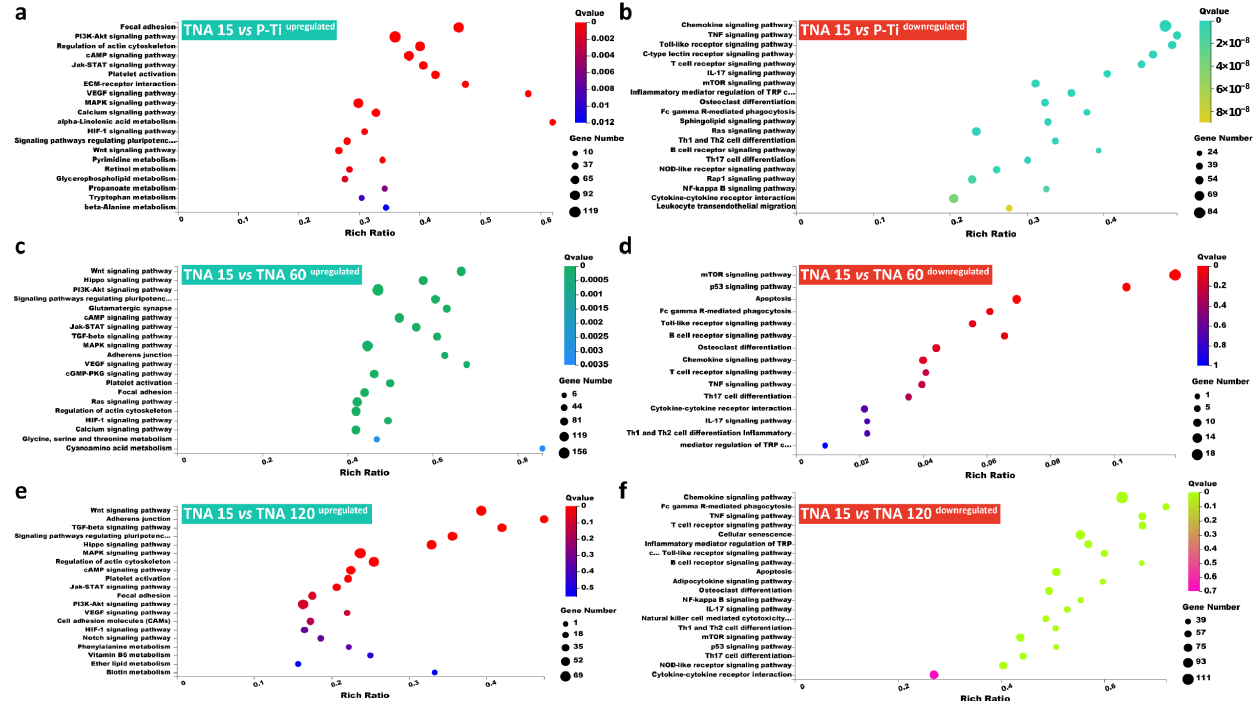
Figure 6. ( a ) KEGG pathway enrichment analysis of the upregulated LncRNAs targeted mRNAs within the comparison TNA 15 vs. P-Ti. ( b ) KEGG pathway enrichment analysis of the downregulated LncRNAs targeted mRNAs within the comparison TNA 15 vs. P-Ti. ( c ) KEGG pathway enrichment analysis of the upregulated LncRNAs targeted mRNAs within the comparison TNA 60 vs. P-Ti. ( d ) KEGG pathway enrichment analysis of the downregulated LncRNAs targeted mRNAs within the comparison TNA 60 vs. P-Ti. ( e ) KEGG pathway enrichment analysis of the upregulated LncRNAs targeted mRNAs within the comparison TNA 120 vs. P-Ti. ( f ) KEGG pathway enrichment analysis of the downregulated LncRNAs targeted mRNAs within the comparison TNA 120 vs.